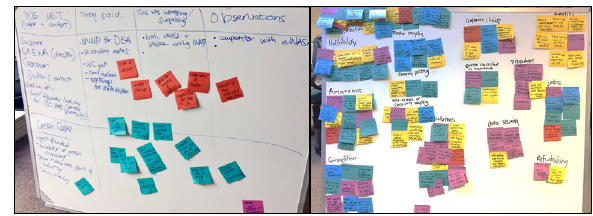
Figure 1: Interview matrix unpacking and theme